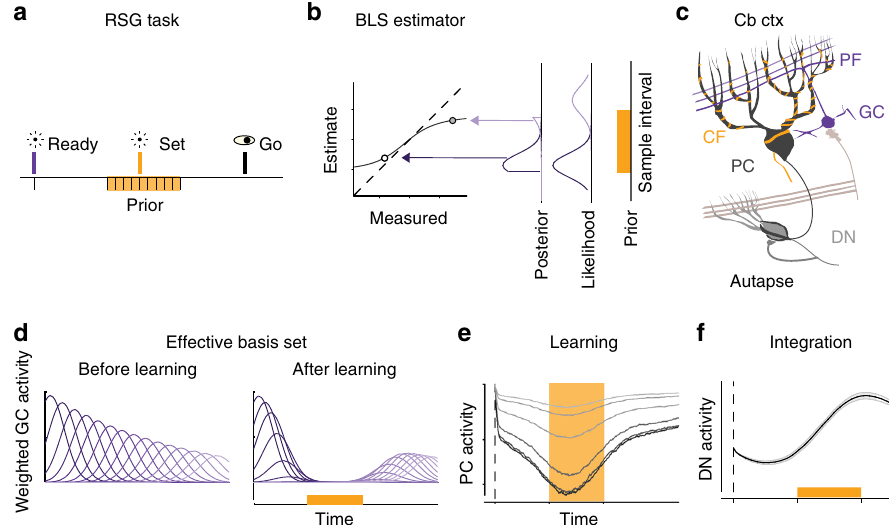
Fig. 1 Task, cerebellar anatomy and the TRACE model. a Ready-Set-Go task. On each trial, participants measure a sample interval demarcated by two visual fl ashes – Ready (purple bar) and Set (orange bar) – and aim to reproduce that interval immediately after Set (Go). The sample interval is drawn from a uniform prior distribution (orange distribution). b The Bayes-Least-Squares (BLS) estimator. A Bayesian observer computes the posterior based on the product of the prior and the likelihood function, and uses the mean of the posterior to estimate the interval. The plot shows the behavior of BLS for two measurements. The light and dark bell-shaped curves represent the likelihood function associated with those measurements. The BLS estimate is the expected value of the posterior, which is biased toward the mean of the prior (arrows) and away from the unity line (dashed). Due to scalar variability, the likelihood is wider for longer measurements (lighter likelihood function), resulting in a larger bias. c Schematic drawing of the relevant part of the cerebellar circuit. In the cerebellar cortex (Cb ctx), a Purkinje cell (PC, black) receives inputs from granule cells (GC, purple) via parallel fi bers (PF), and from climbing fi bers (CF, orange). PCs, in turn, project to and inhibit neurons in the dentate nucleus (DN), which additionally receive extra-cerebellar input (light brown) and autaptic (synapse onto self) input. d The effective basis set in TRACE, which re fl ects the GC basis set scaled by the GC to PC synaptic weights (i.e., Weighted GC activity). The plot shows weighted GC activity for a subset of GCs in the model. Left: Weighted GC activity before learning (sub-sampled). Right: Weighted GC activity after learning the prior. e PC activity pro fi le based on TRACE simulations at different stages of learning. The PC activity is shown after 10, 50, 100, 150, and 200 trials during learning (light to dark). f DN activity. The activity pro fi le of DN re fl ects the integrated output of PCs, and is plotted after learning (trial 200). Shaded gray region indicates standard deviation. Traces in e and f do not correspond to any speci fi c sample interval; instead, they show the expected response pro fi les in the absence of CF input (i.e., as if Set were never presented). Dashed lines in e and f correspond to the time of Ready, and the orange regions highlight the domain of the